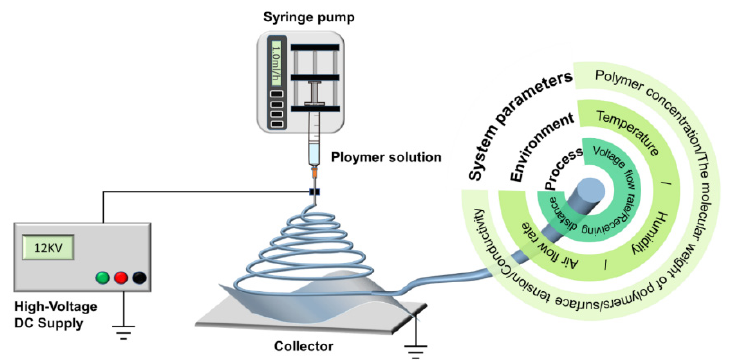
Figure 5. Schematic diagram of high-voltage electrospinning and the factors influencing the diam- of eter of nanofibers.